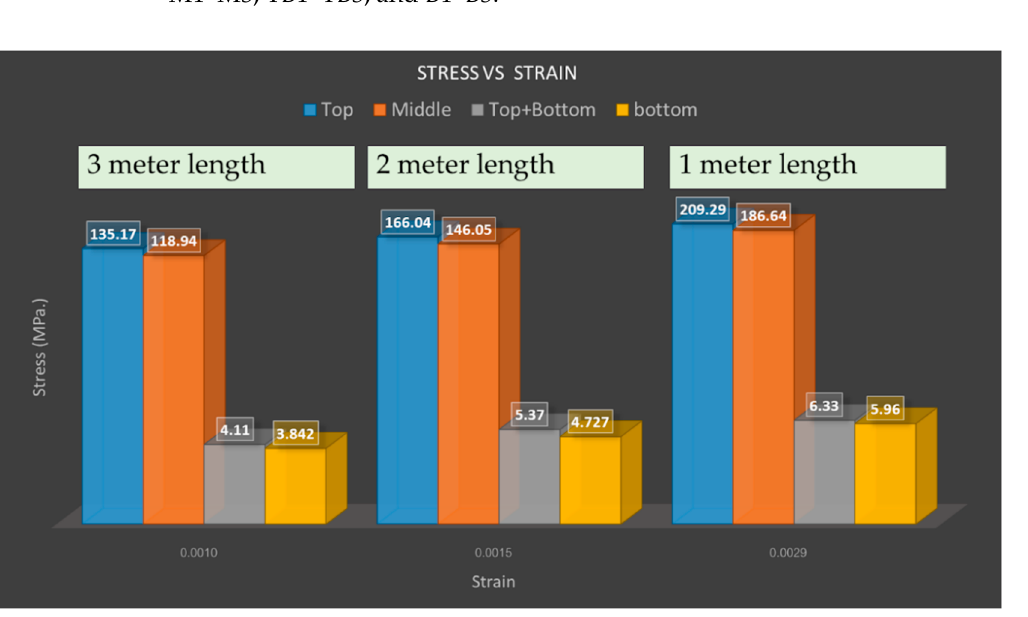
Figure 17. Stress vs strain.